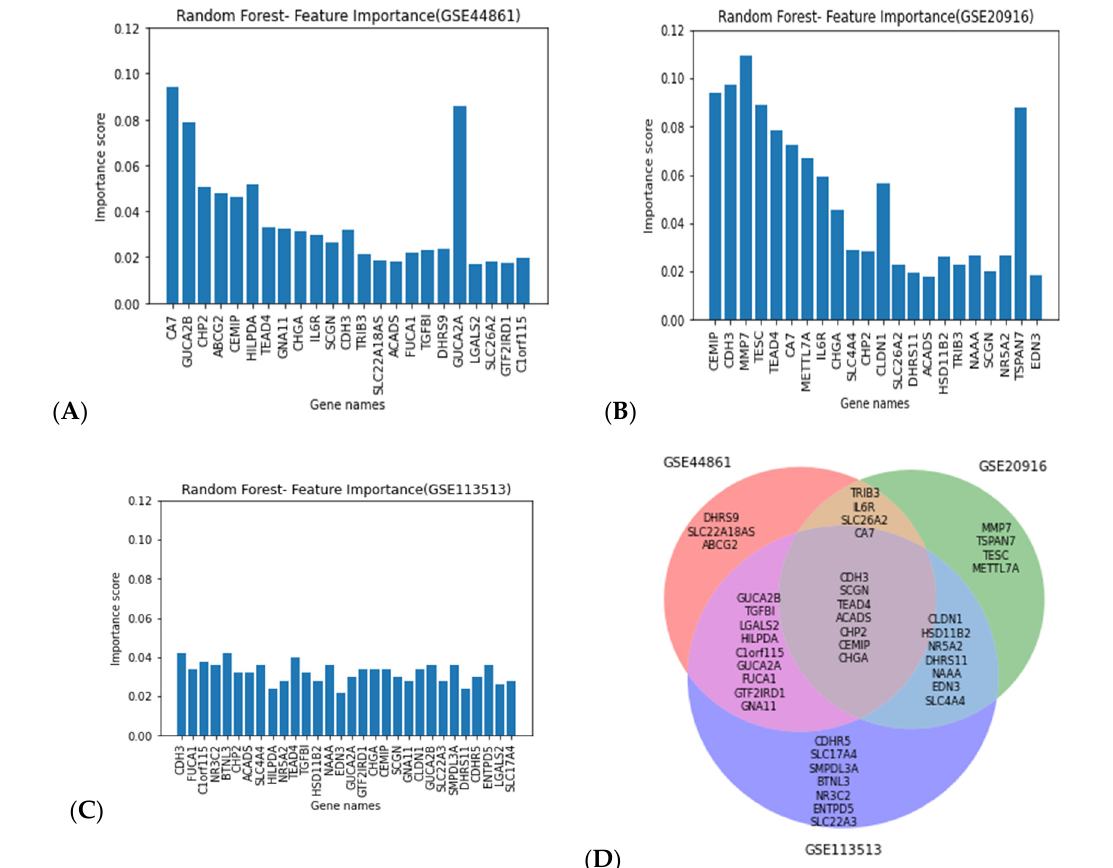
Figure 4. Important genes selected using the mean decrease in impurity (MDI) technique in combi- nation with random forest classifier. The X -axis represents the gene names, and the Y -axis repre- sents importance score values across the GSE44861 ( A ), GSE20916 ( B ), and GSE113513 datasets ( C ). The common genes from all three datasets ( D